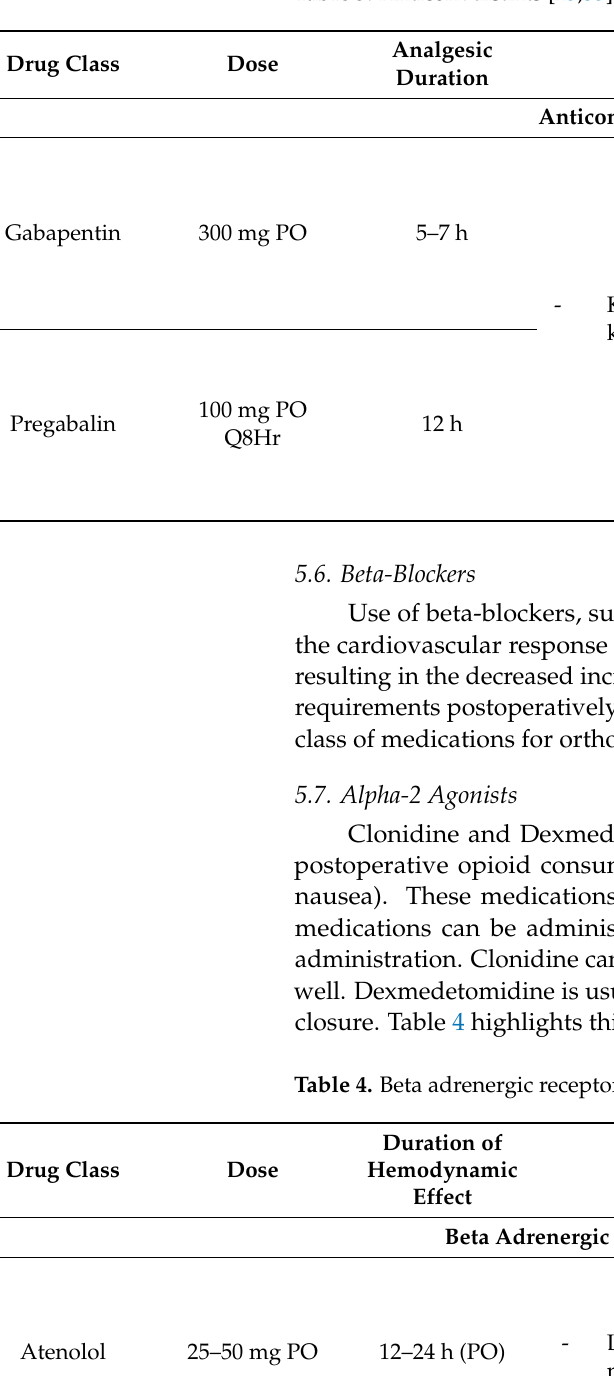
Table 3. Anticonvulsants [25,35].